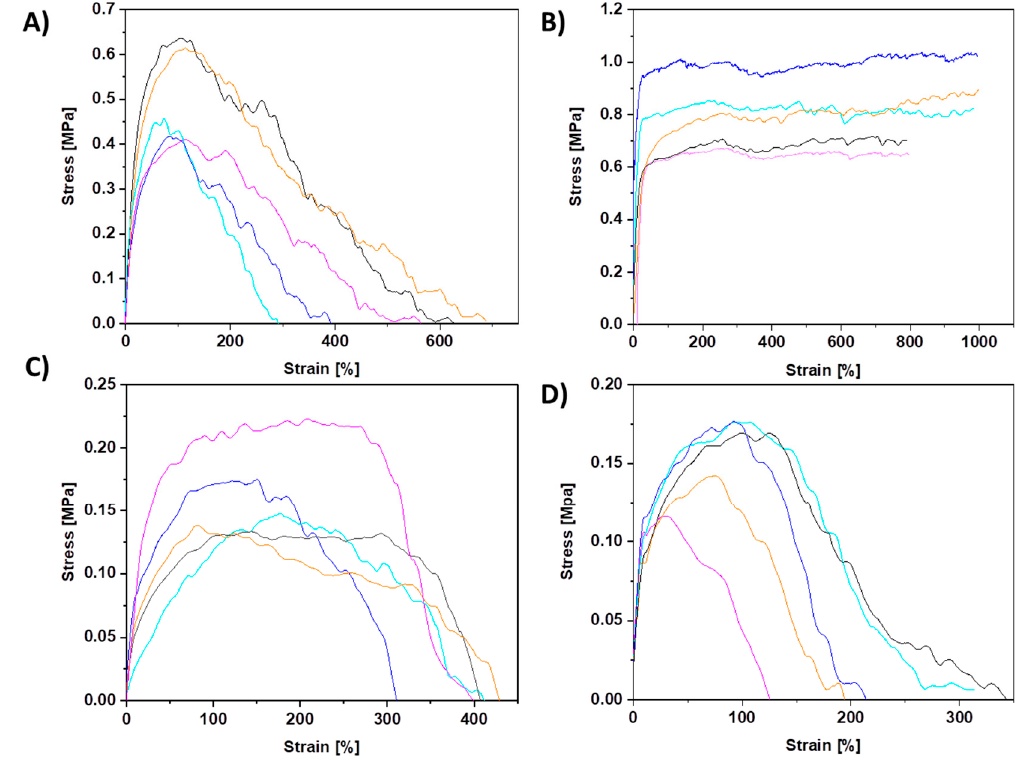
Figure 3. All stress–strain curves of PCL samples from tensile testing for ( A ) sPCL random, ( B ) sPCL aligned, ( C ) pPCL random, and ( D ) pPCL aligned fibers. Table 2. The average values from mechanical testing of the PCL fiber mats showing: σ max tensile strength, Ɛ max strain at max strength, and Ɛ f strain at failure.